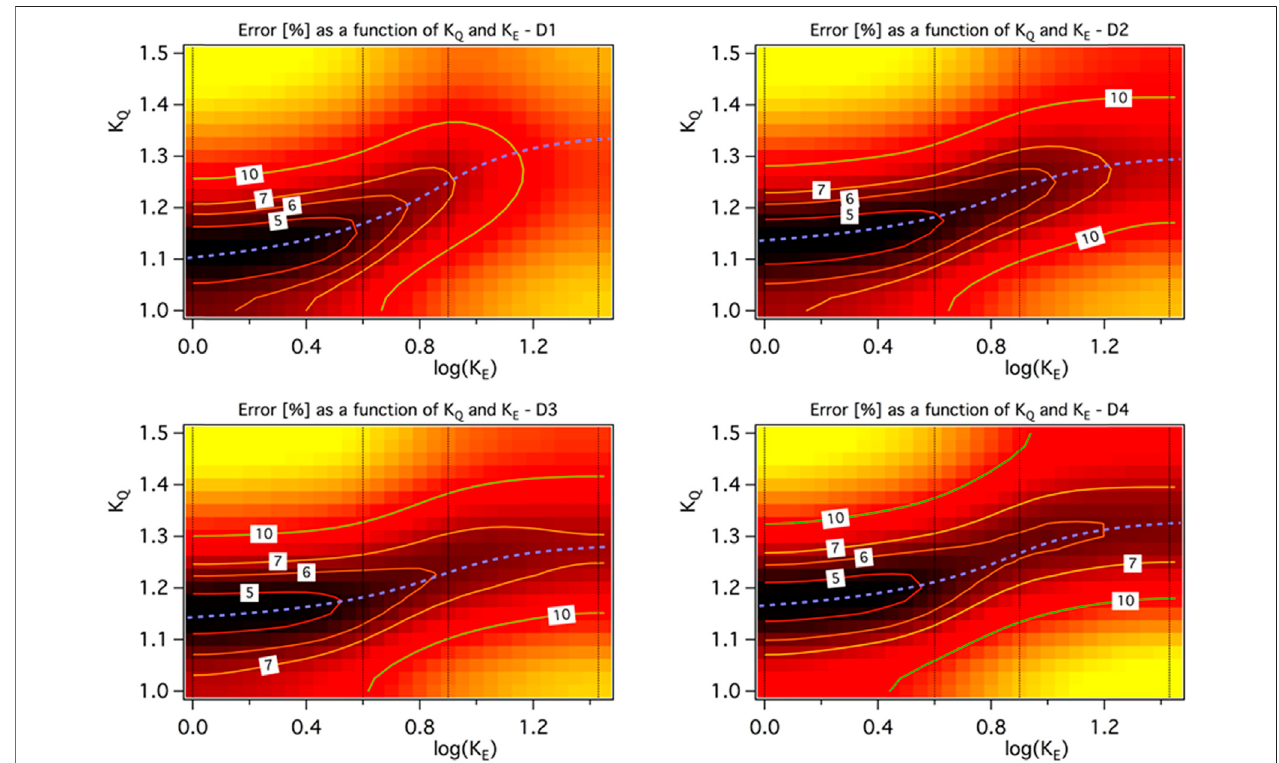
FIGURE 11 | Domain of computation accuracy as a function of K E and K Q for the experiment cases D1-D4 (effect of dwell time). The minimum error is pointed out with a blue dashed line.